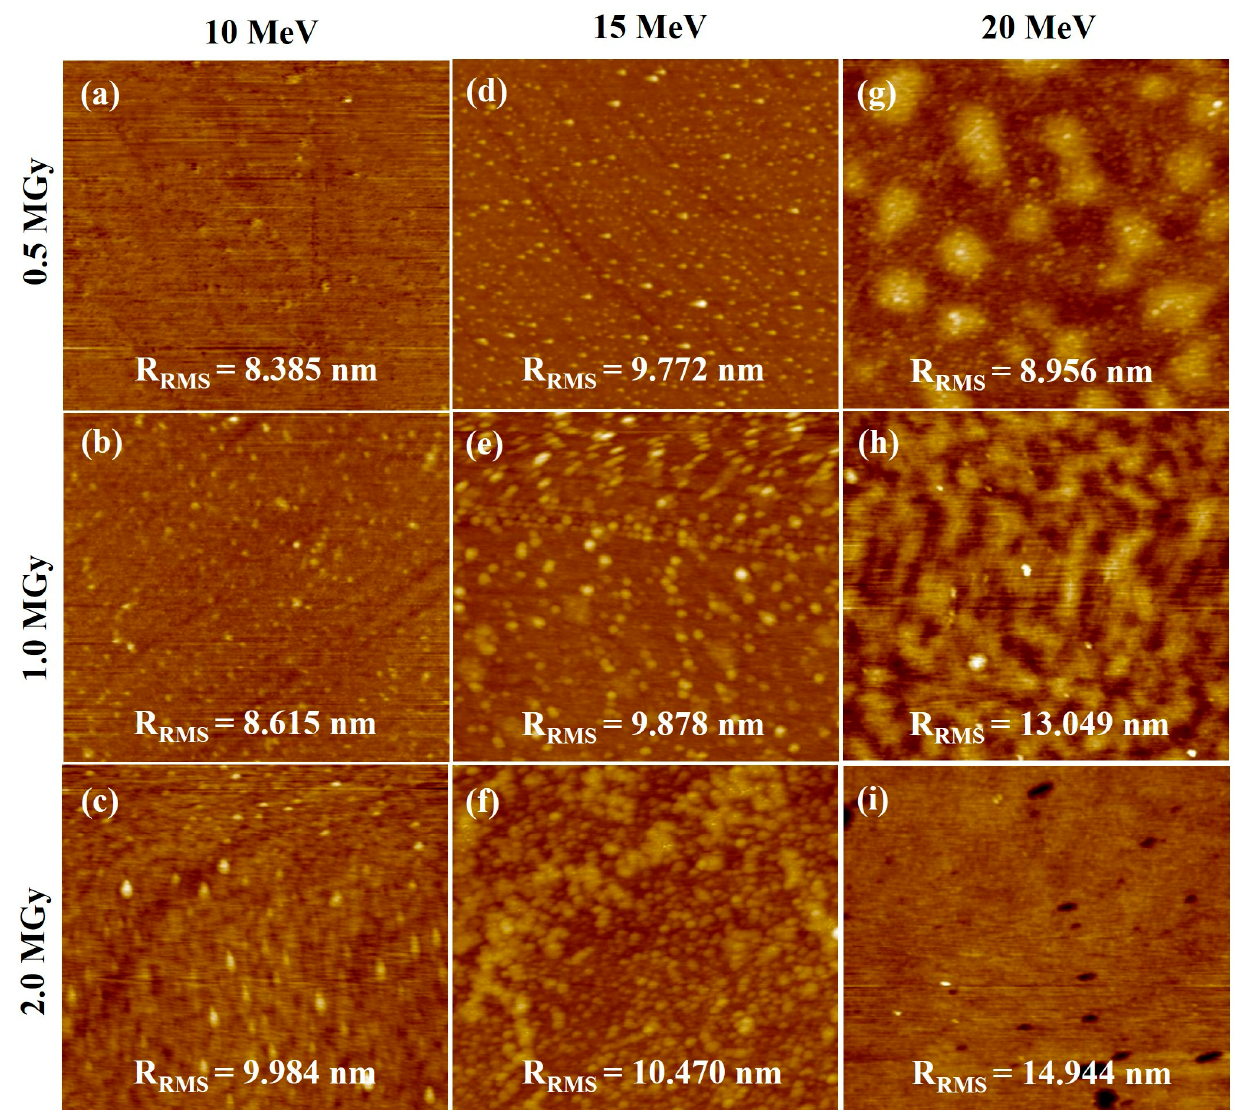
Figure 3. AFM images of the irradiated GaAs samples with electron energies of 10 ( a – c ), 15 ( d – f ), 20 ( g – i ) MeV for electron doses of 0.5, 1.0, and 2.0 MGy, respectively.